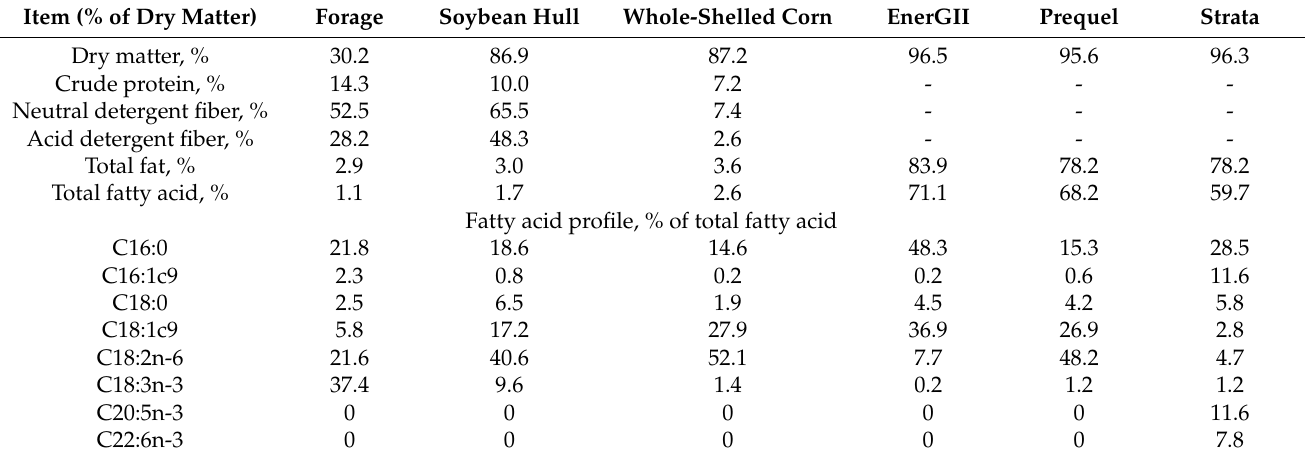
Table 2. Nutritional and fatty acid profiles of ingredients fed to cows for the last 82 ± 5 d of gestation 1